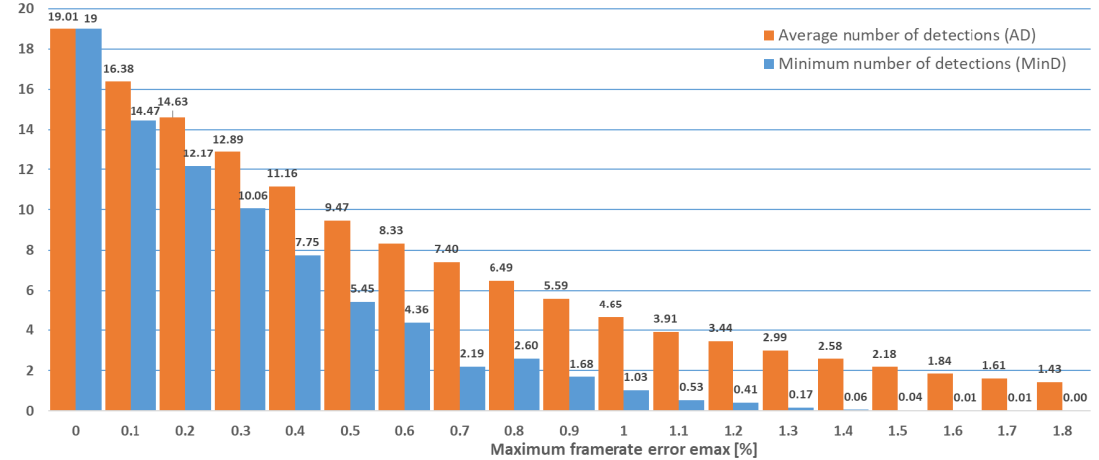
Figure 5. Minimum number of detections (MinD) and average number of detections (AD) out of a maximum of 20 (120 frames per second case).